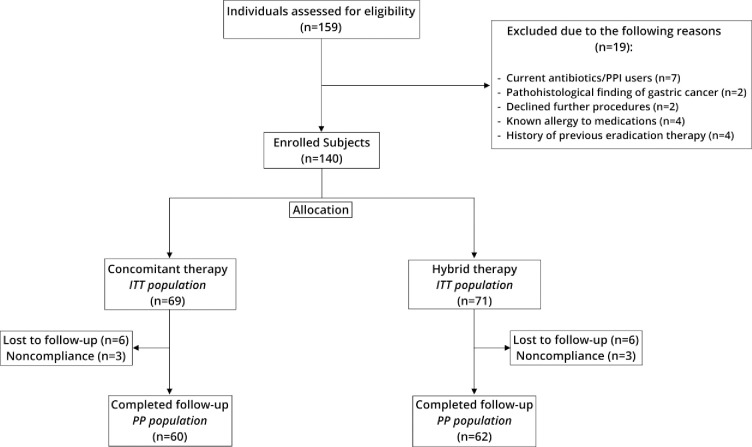
Study flowchart.